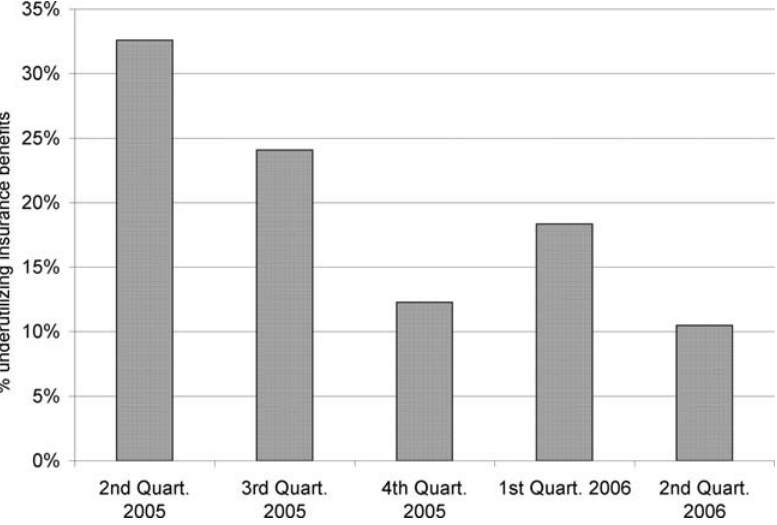
Figure 1. Insurance underutilization in QIDS sites by quarterly monitoring period (2005–2006).